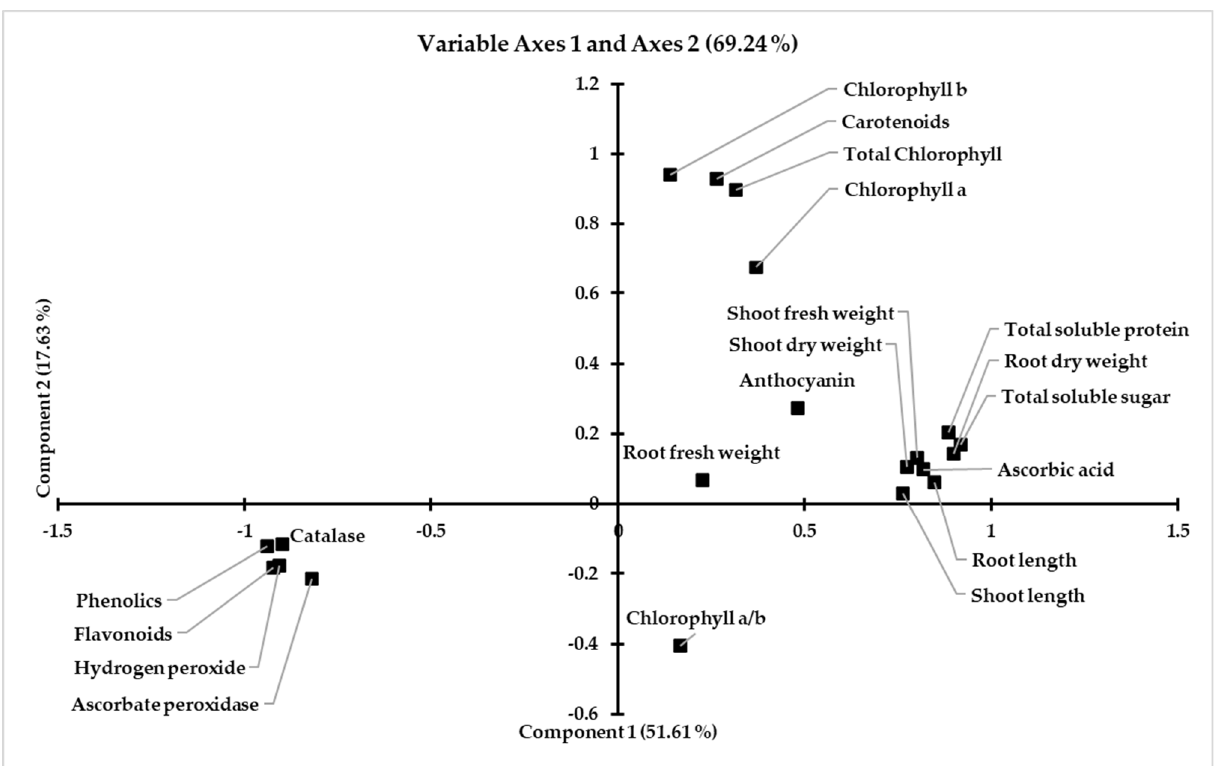
Figure 4. Component plot in the rotated space by the factor analysis of the studied parameters of wheat treated with bacteria, fungi and L ‐ proline under control (0 mg/kg soil) and cadmium containment soil (40, 80 mg/kg soil) conditions.